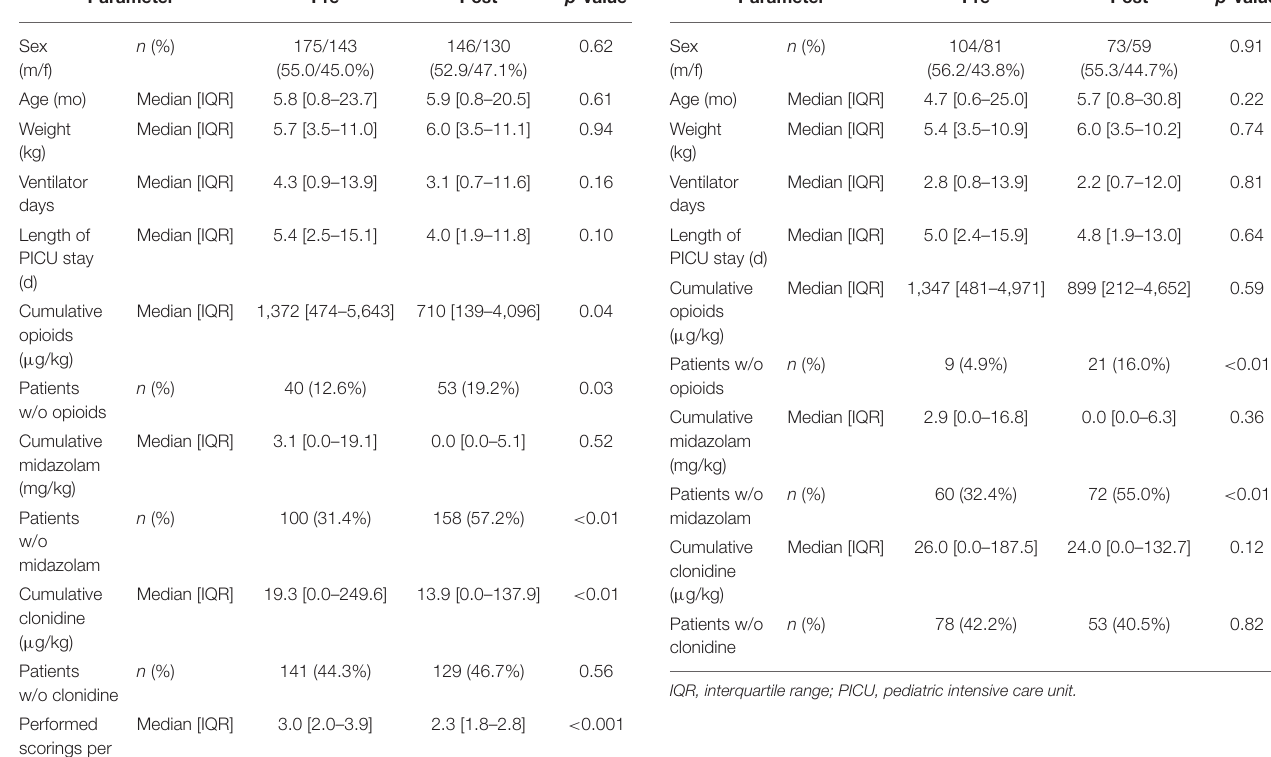
TABLE 4 | Differences of patients’ characteristics between the pre-implementation group and post-implementation group in patients with congenital heart disease. Parameter Pre